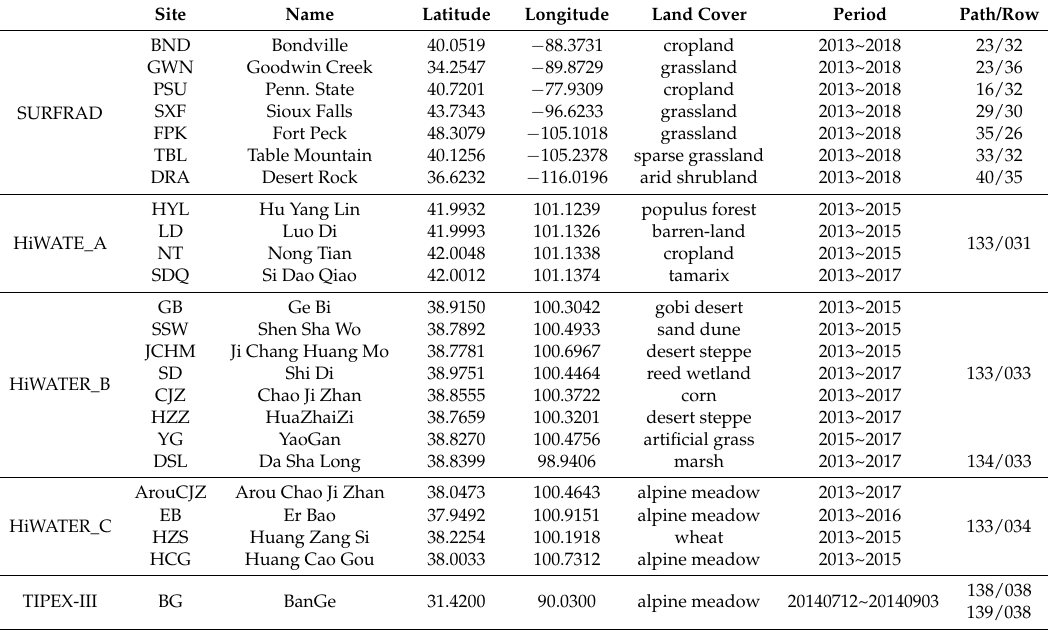
Figure 2. Distribution of Surface Radiation Budget Monitoring (SURFRAD) sites in the USA, Heihe Watershed Allied Telemetry Experimental Research (HiWATER) sites, and BanGe site in China. Table 1. In-situ sites’ information and the corresponding path/row of Landsat